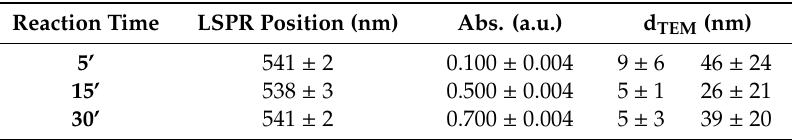
Table 5. UV-Vis ad TEM details of